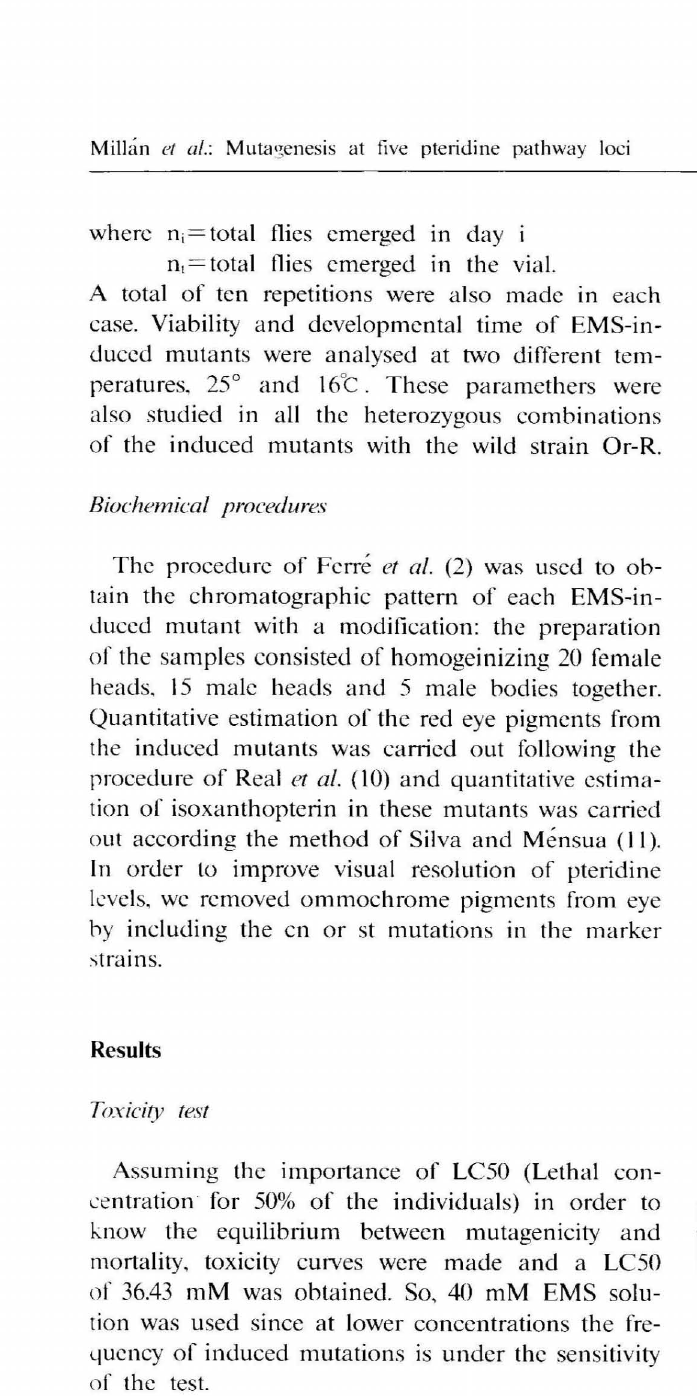
Figure 2. Order of appearance of the induced mutants through the